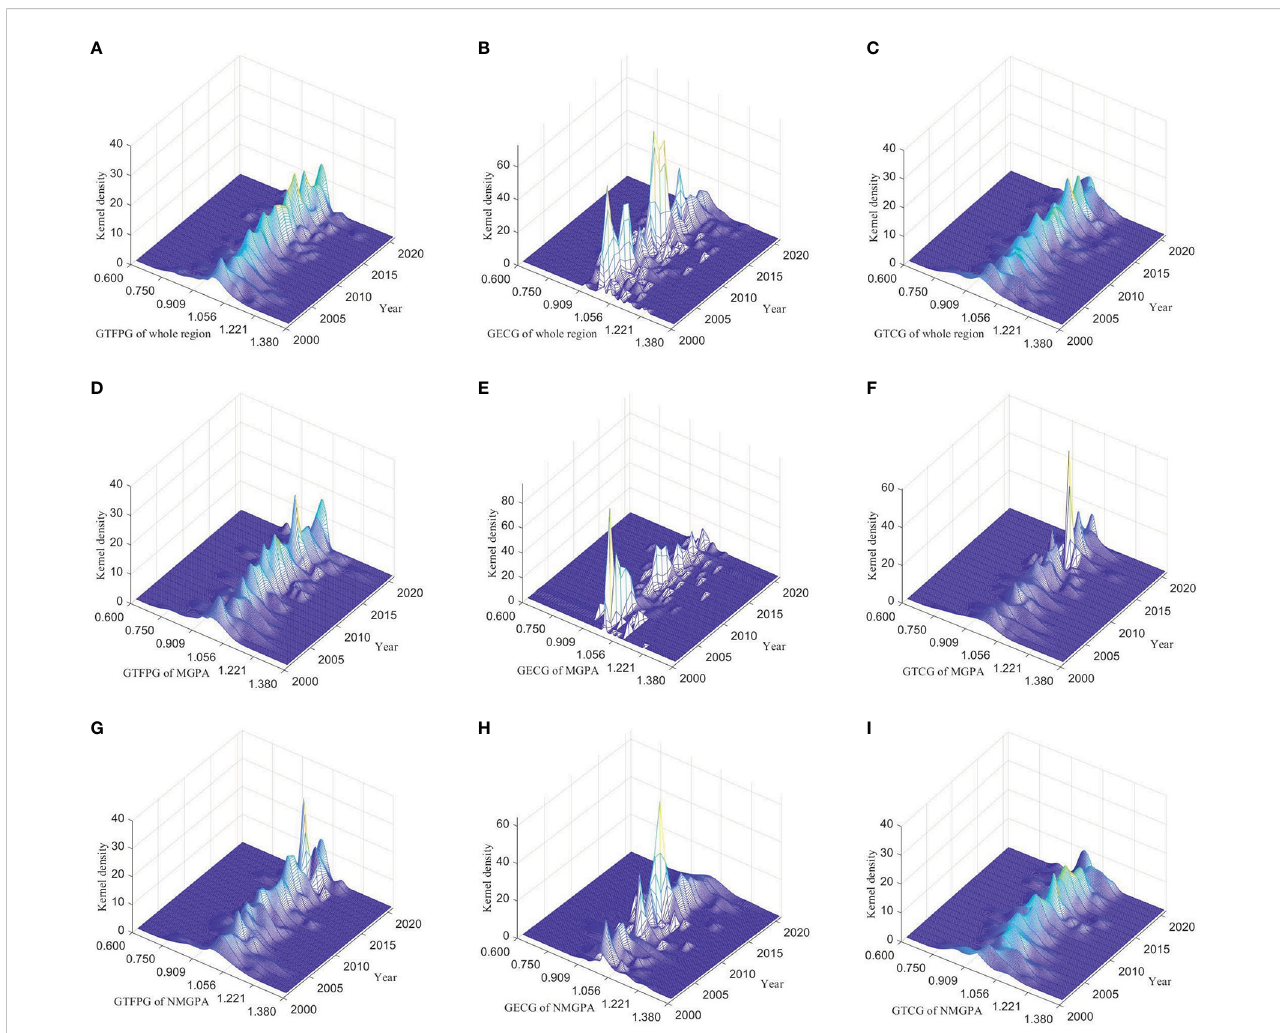
FIGURE 4 Three-dimensional kernel density curves of GTFPG, GECG and GTCG. MGPA: major grain producing areas; NMGPA: non-major grain producing areas. (A – C) are kernel density curves of GTFPG, GECG and GTCG of the whole region respectively. (D – F) are kernel density curves of GTFPG, GECG and GTCG of the major grain producing areas respectively. (G – I) are kernel density curves of GTFPG, GECG and GTCG of the non-major grain producing areas